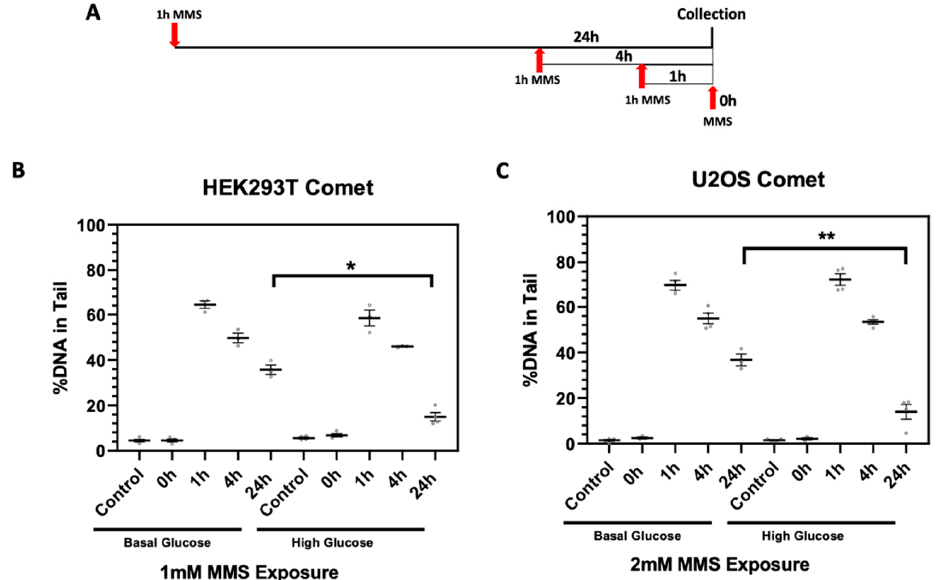
Figure 5. Comet assay showed increased DNA repair following acute high glucose exposure. ( A ) Timeline of MMS dosing for the comet assay. ( B ) The % DNA in the comet tail in basal glucose (BG) and acute high glucose (HG) HEK293T cells at 0, 1, 4, and 24 h repair times post-1 mM MMS exposure. ( C ) The % DNA in the comet tail in BG and acute HG U2OS cells 0, 1, 4, and 24 h post-2 mM MMS exposure. * p < 0.05, ** p < 0.01.